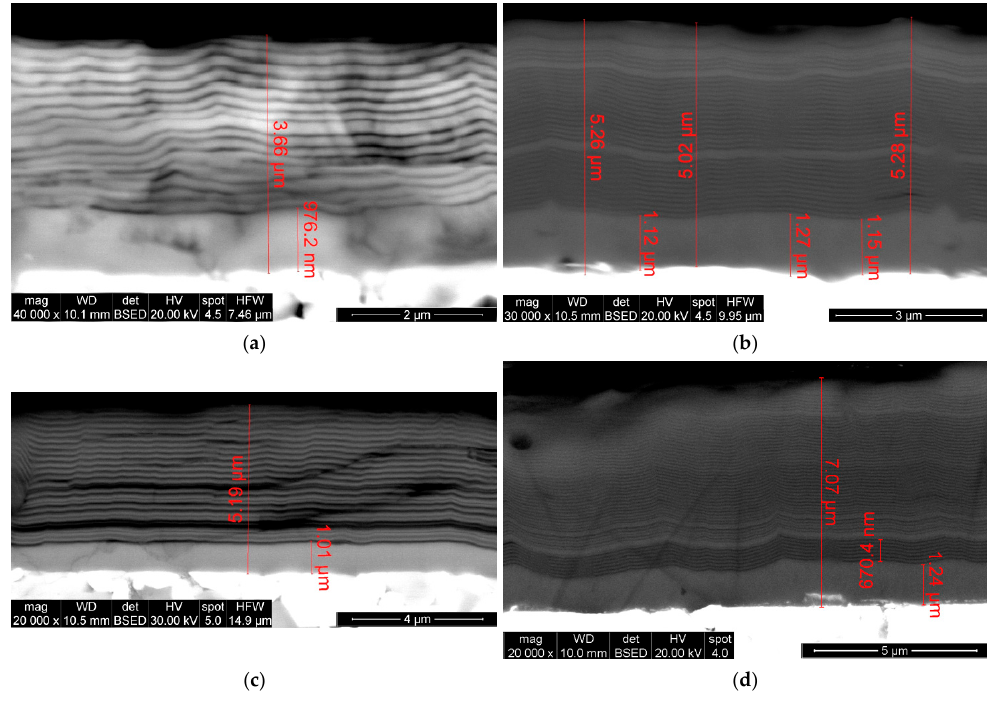
Figure 6. Structure on cross-section of Zr-ZrN-(ZrCrNbAl)N and Ti-TiN-(TiCrAl)N coatings with a thickness of about 5 µm: ( a ) Zr-ZrN-(ZrCrNbAl)N, thickness 3 (±0.7) µm; ( b ) Ti-TiN-(TiCrAl)N, thickness 5 (±0.5) µm; ( c ) Zr-ZrN-(ZrCrNbAl)N, thickness 5 (±0.6) µm; ( d ) Ti-TiN-(TiCrAl)N, thickness 7 (±0.5) µm.